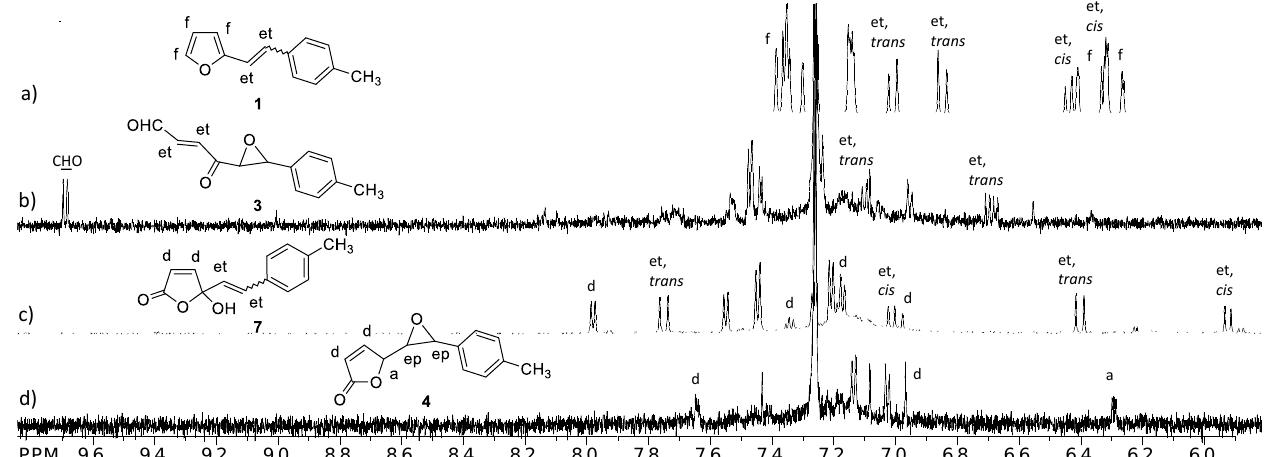
Figure 5. Partial 1 H NMR spectra (CDCl 3 ) of starting compound 1 ( a ), formyl derivative 3 ( b ), unsaturated carbonyl compound 7 ( c ), and epoxy structure 4 ( d ) with characteristic patterns for assignation of the products’ structure.